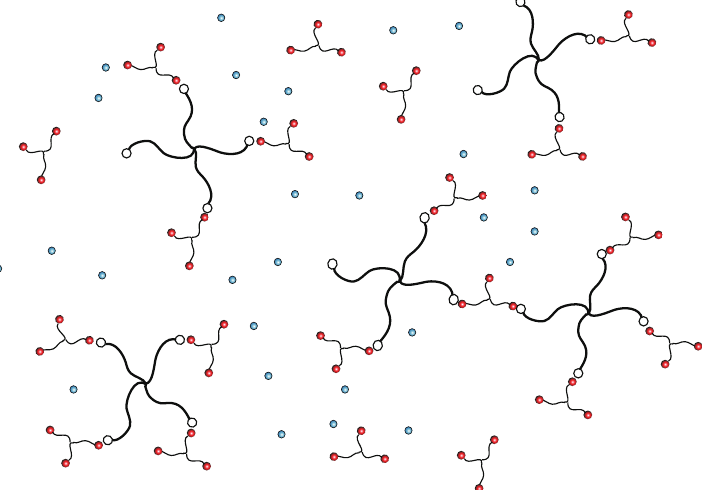
Figure 2. Reentrant sol region at high concentration of B molecules. Most of the clusters consist of small numbers of A molecules whose surfaces are covered by B